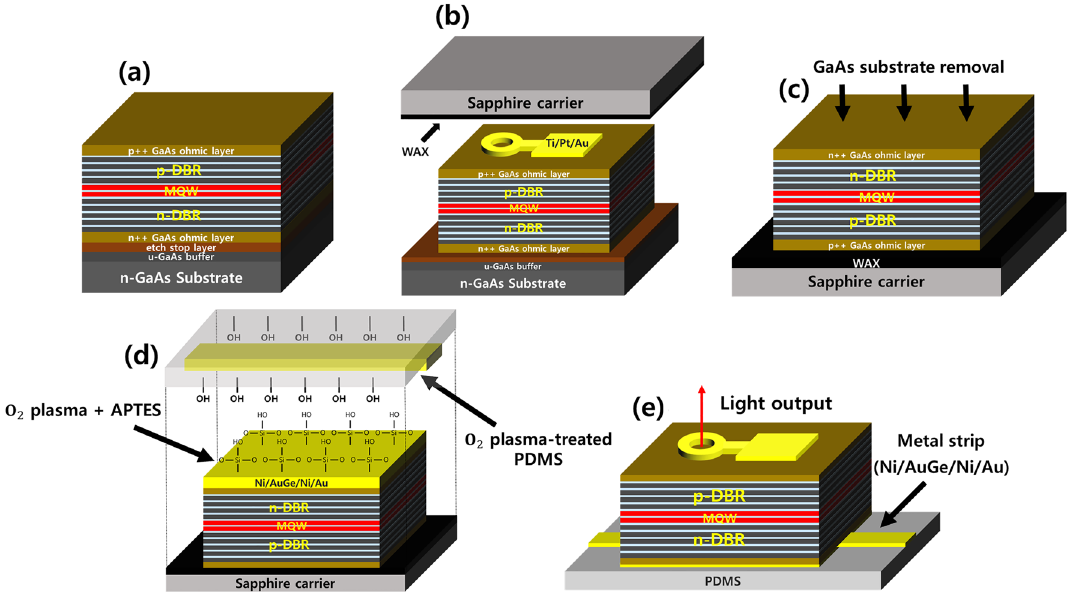
Figure 3. The fabrication process of the thin-film VCSEL transferred onto a PDMS substrate. ( a ) p-on-n structure of the thin-film VCSEL is grown in upward order using an MOCVD system. ( b ) The front-end process is performed including front pattern formation, top-contact (Ti/Pt/Au) metallization, and mesa etching. Subsequently, the front-processed VCSEL is bonded to the sapphire carrier using an Apiezon W wax. ( c ) The 350-μm n-GaAs substrate is removed by the NH 4 OH-based etchant. ( d ) Thin-film VCSEL with Ni/AuGe/Ni/Au is coupled to a PDMS with a metal strip via an SMB technique. ( e ) The top-emitting thin-film 930 nm VCSEL is fabricated onto a PDMS by removing the sapphire